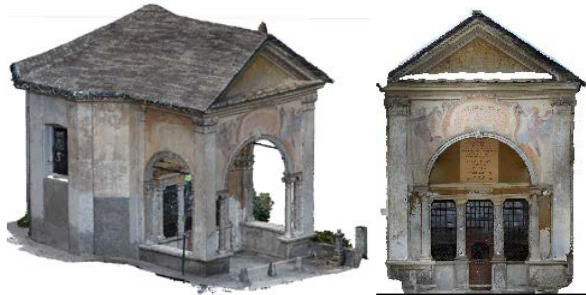
Figure 6: Photogrammetric (terrestrial and UAV – average GSD ~ 3m) point cloud of Chapel two (architectural scale) on the left, orthoimage of the main façade on the right.